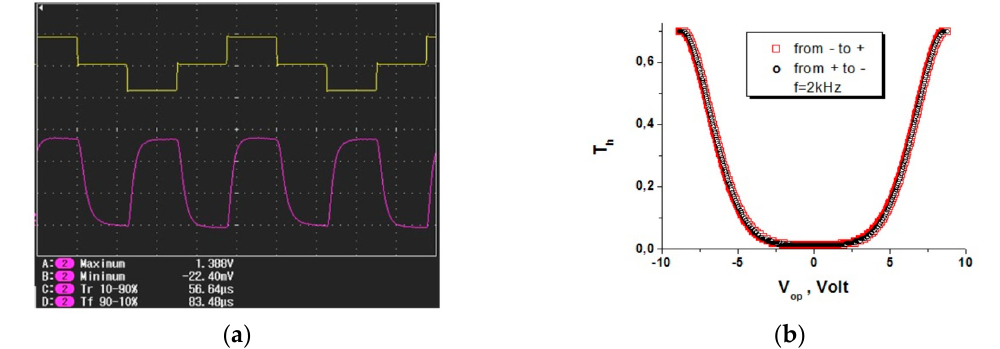
Figure 11. Symmetric (voltage sign independent) electro-optic response of DHF–FLC [31]. ( a ) Top—the driving voltage waveform applied to the cell, bottom—the electro-optical response of the cell. ( b ) V-shaped mode in the envelope curve of light transmission saturation states measured at electro-optical response frequency 2 kHz. The light transmission T h evaluated in comparison with transmission of empty cell placed between parallel polarizers; this transmission is defined as T h = 1.